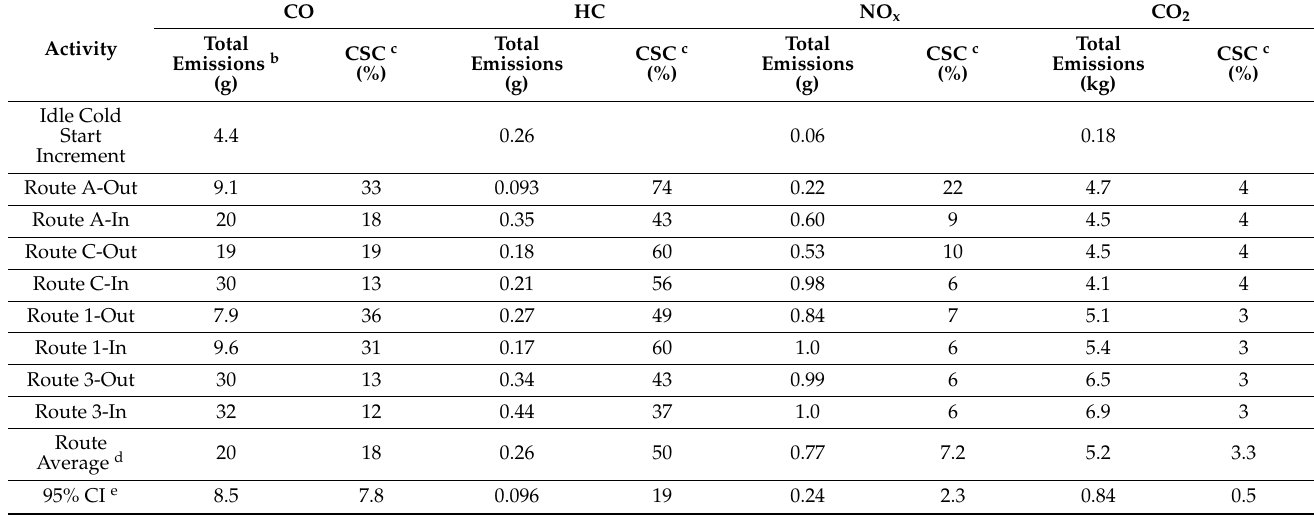
Table 3. Idle cold start increment, hot-stabilized trip total emissions, and cold start contributions (CSC) for each trip, based on measured data for a 2008 Chevrolet Impala a